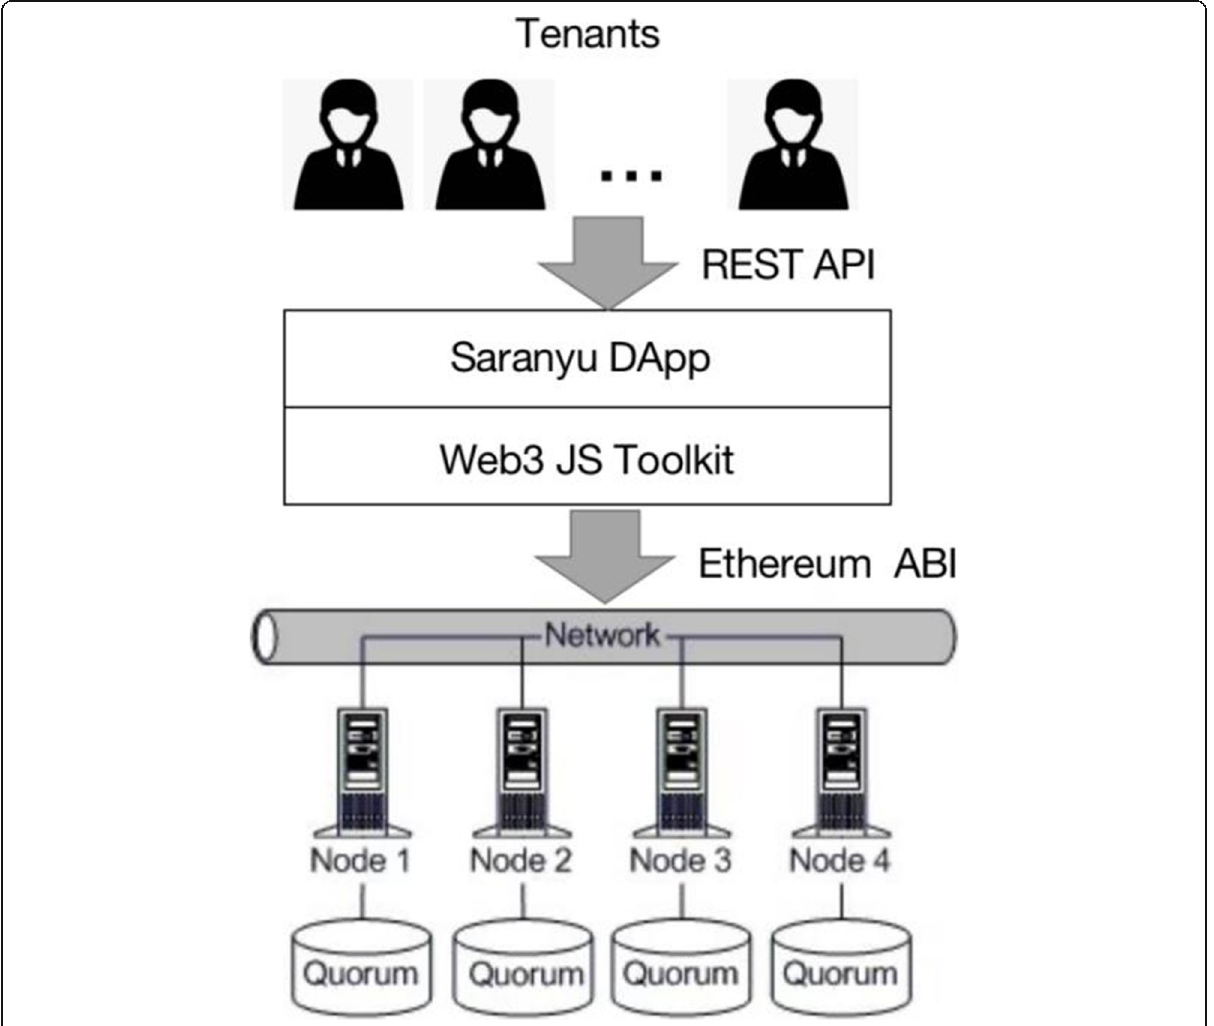
operation of the platform. Figure 4 shows the architec- ture of